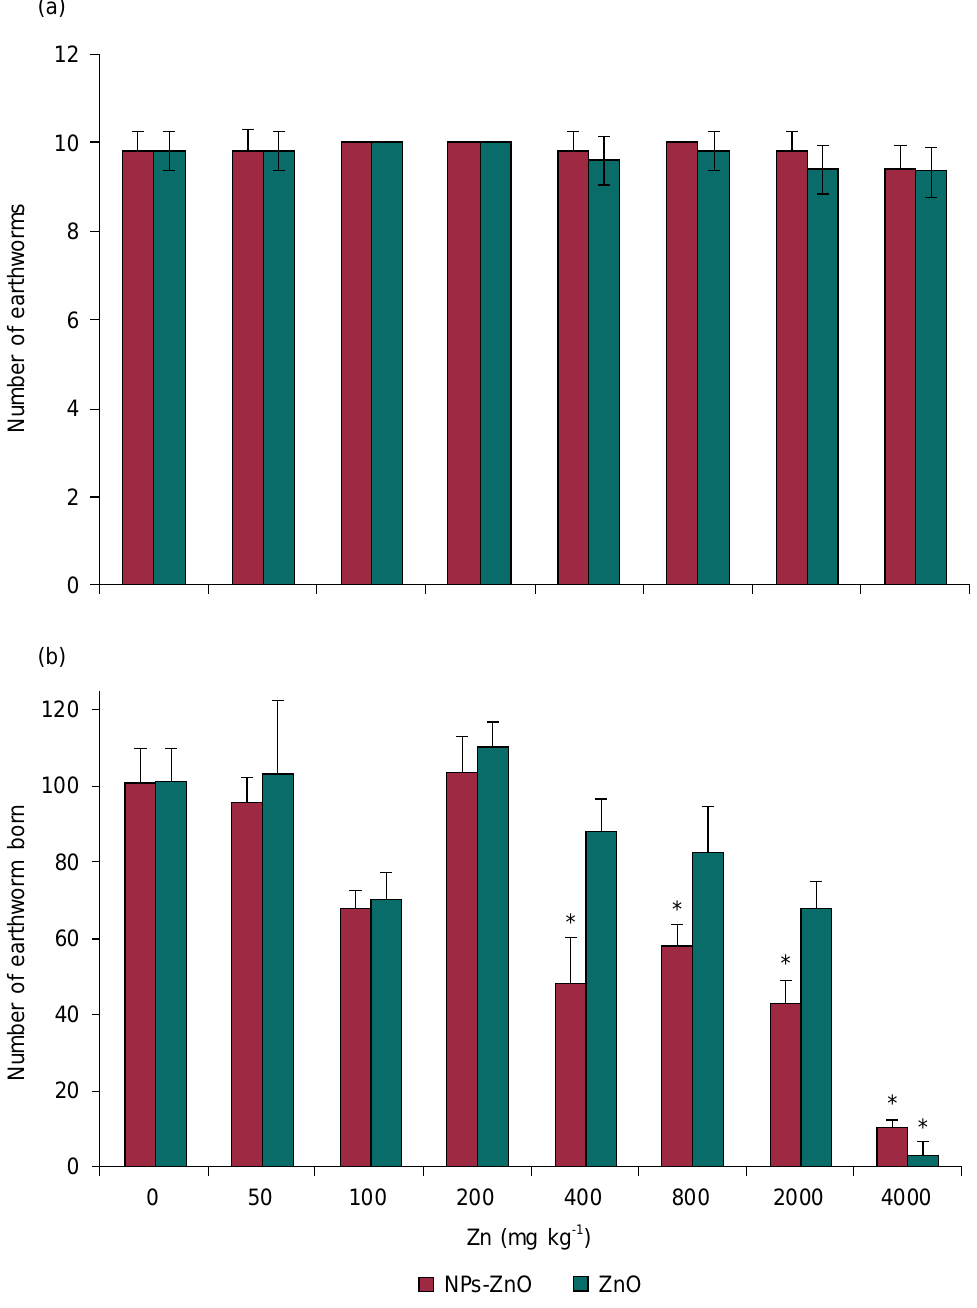
Figure 2. Mean number and standard deviation of live adults (a) and juveniles per treatment (b) E. andrei , in an Entisol contaminated with zinc oxide nanoparticles (NPs-ZnO) and non-nano zinc oxide (ZnO). * Significant reduction (p<0.05) for treatment (50, 100, 200, 400, 800, 2,000, and 4,000 mg kg -1 , dose-dependent effect) compared to the control (0 mg kg -1